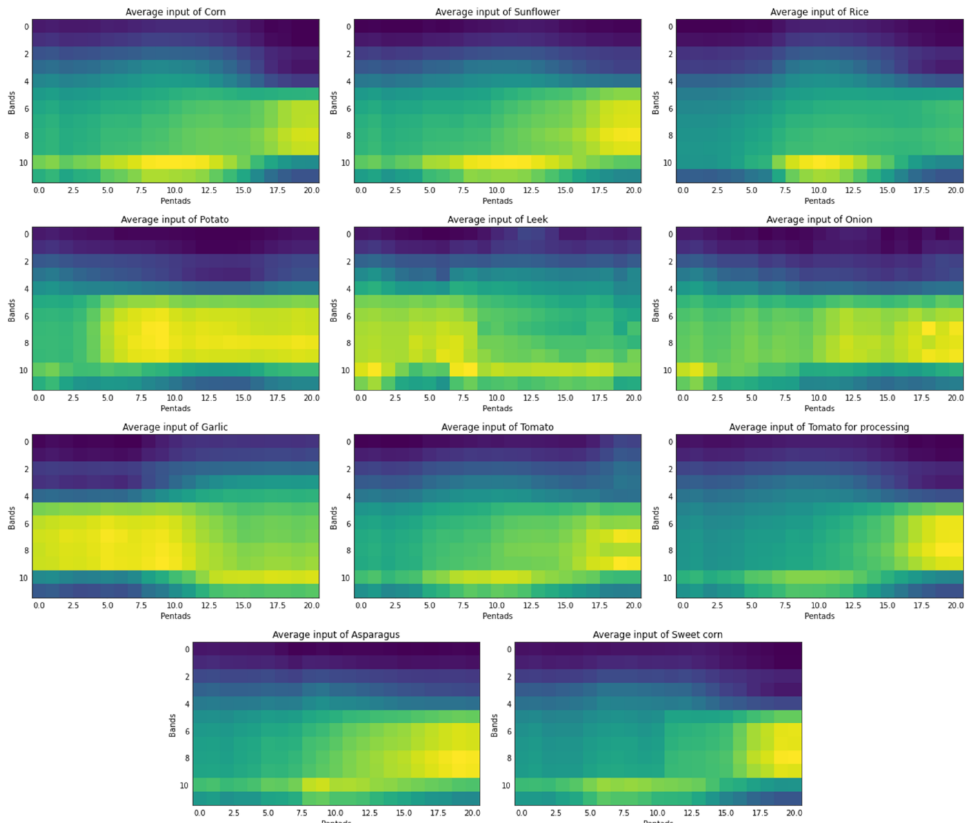
Figure 7. Average input of each of the studied crops. Representation of the 2019 average of training entries per